Question: What kind of plot is shown here?
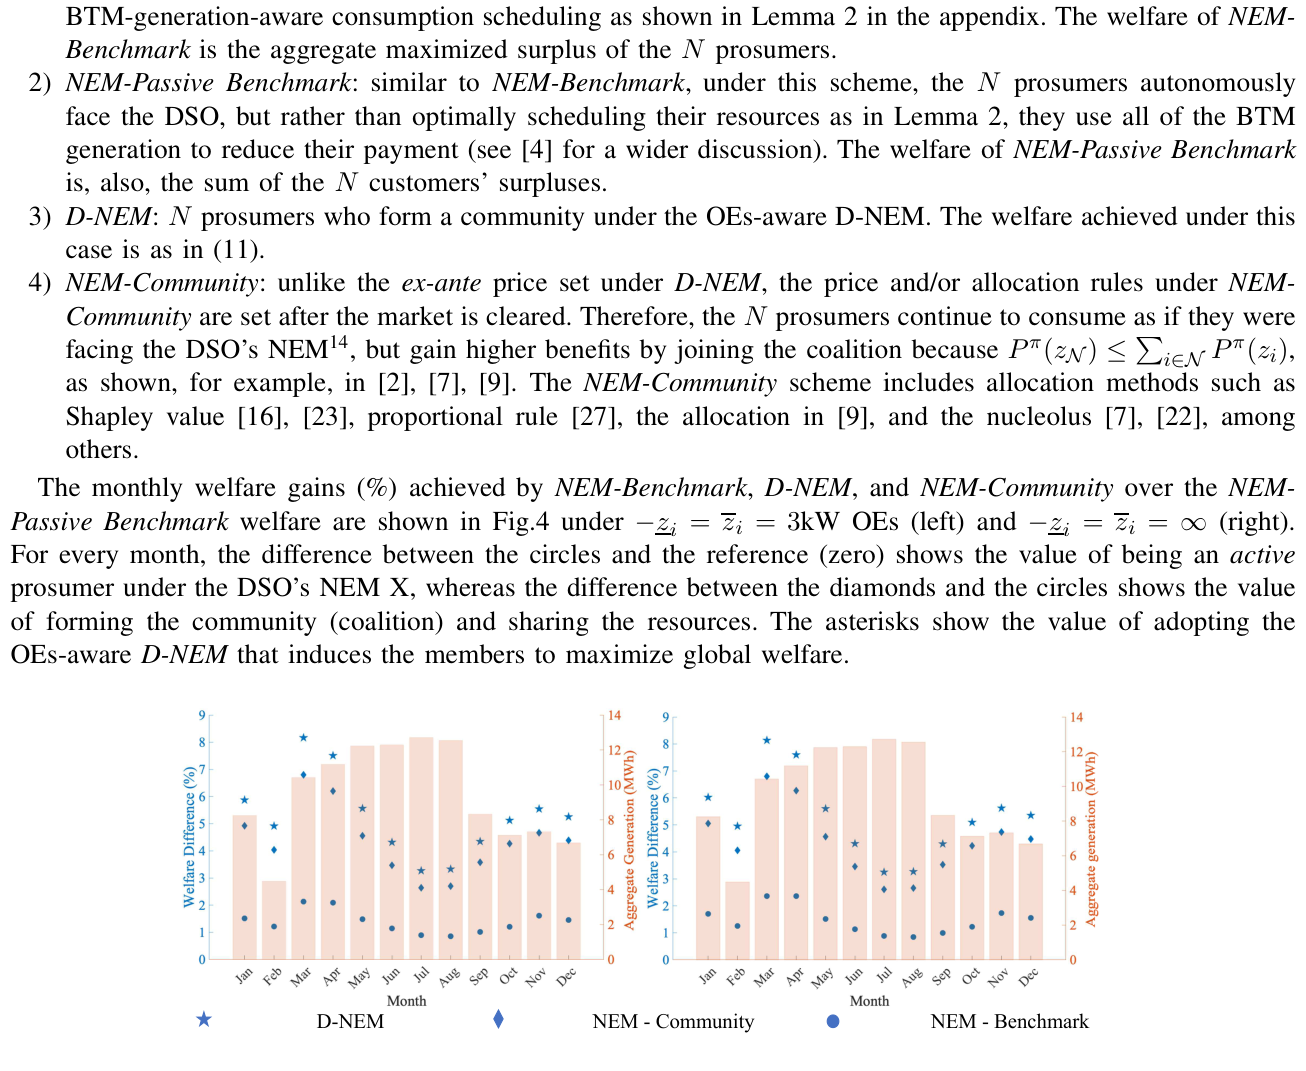
Answer: bar